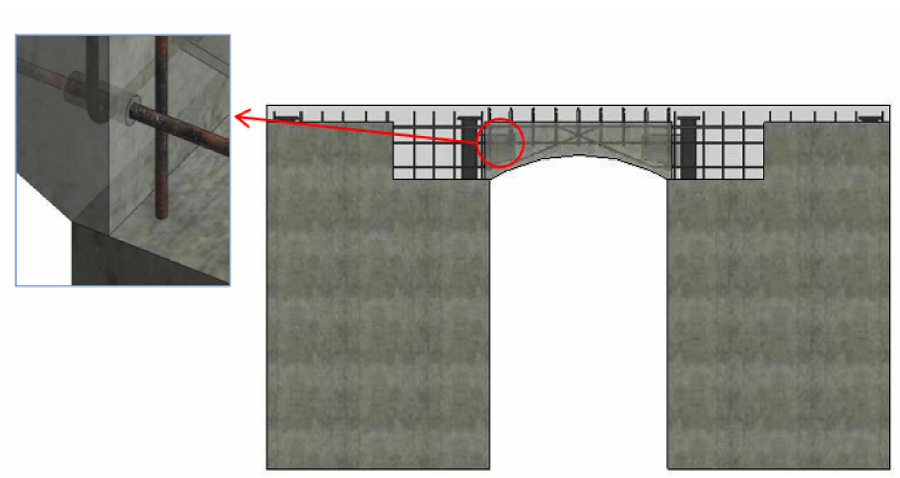
Figure 4. Mechanical connection of the bars between the wall and